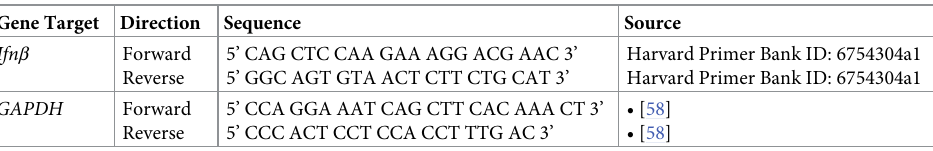
Table 1. Primer sequences used for